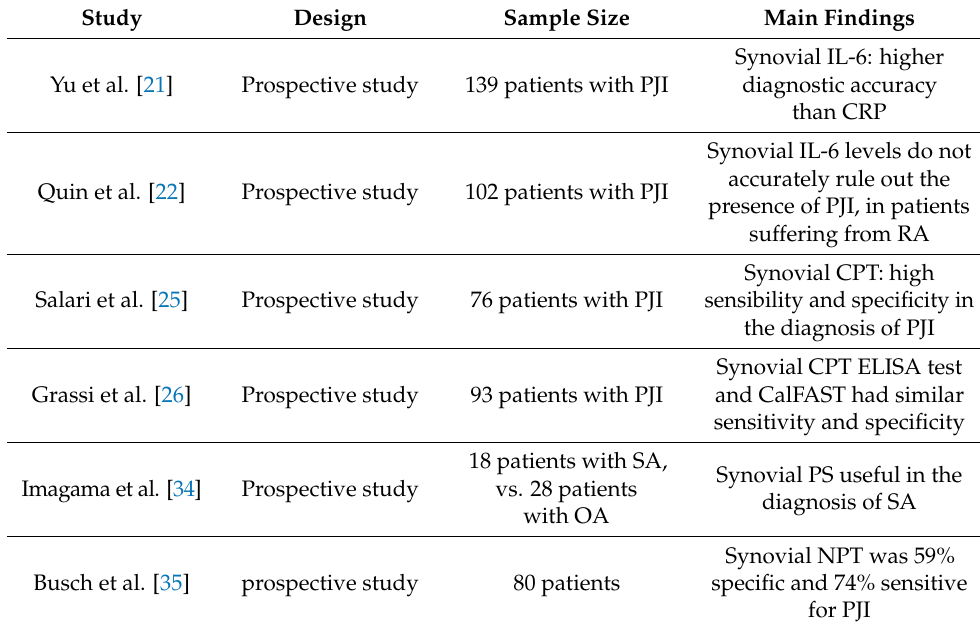
Table 2. Main data of studies focusing on emerging synovial fluid biomarkers for PJI diagnosis.